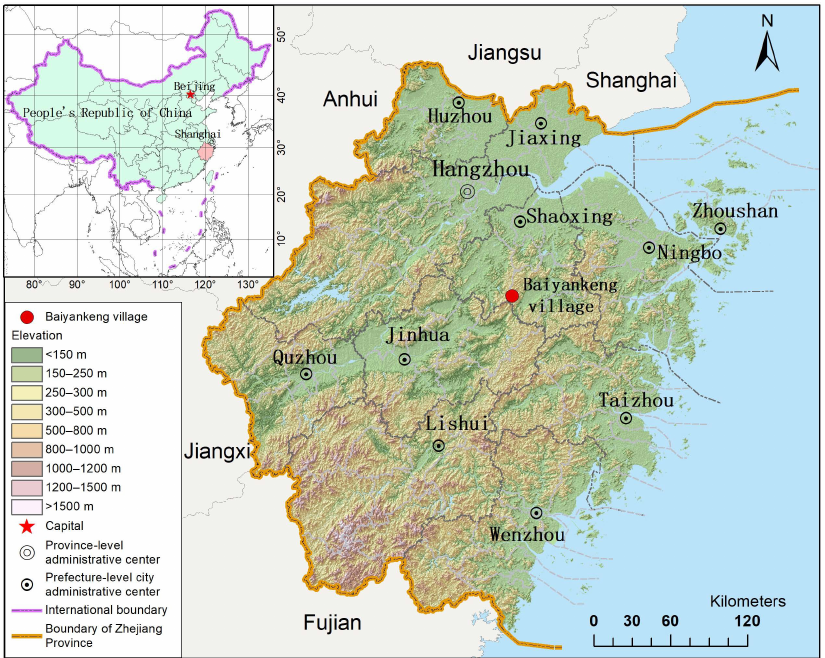
Figure 1. The location of Baiyankeng village in Zhejiang Province, China (30 m DEM database from the Geospatial Data Cloud, 2019, https://www.gscloud.cn/home, accessed on 1 May 2021).